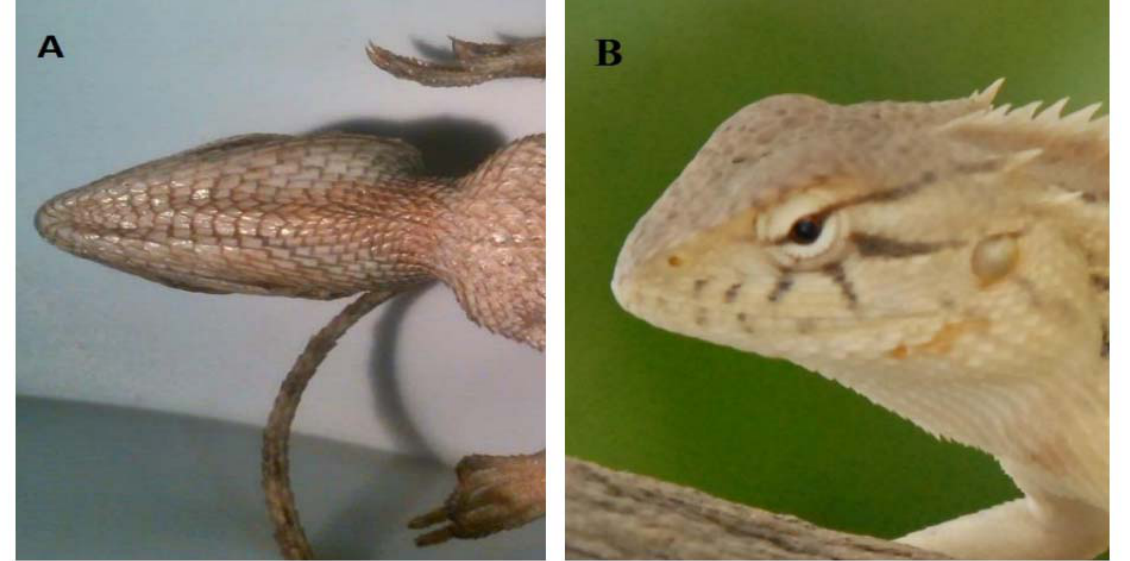
F IGURE 3. Calotes versicolor : (A) head from ventral; (B) head from